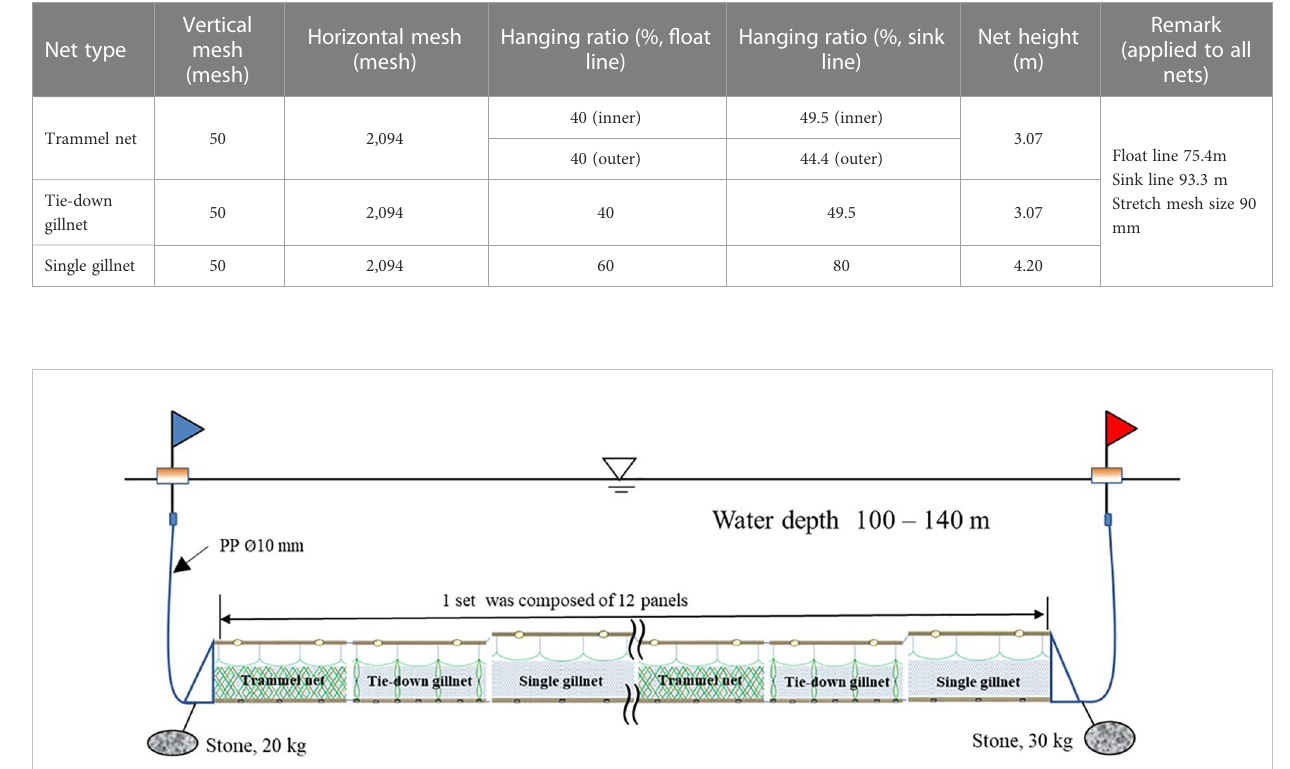
FIGURE 3 Arrangement of three types of gillnets for fi shing performance experiments.